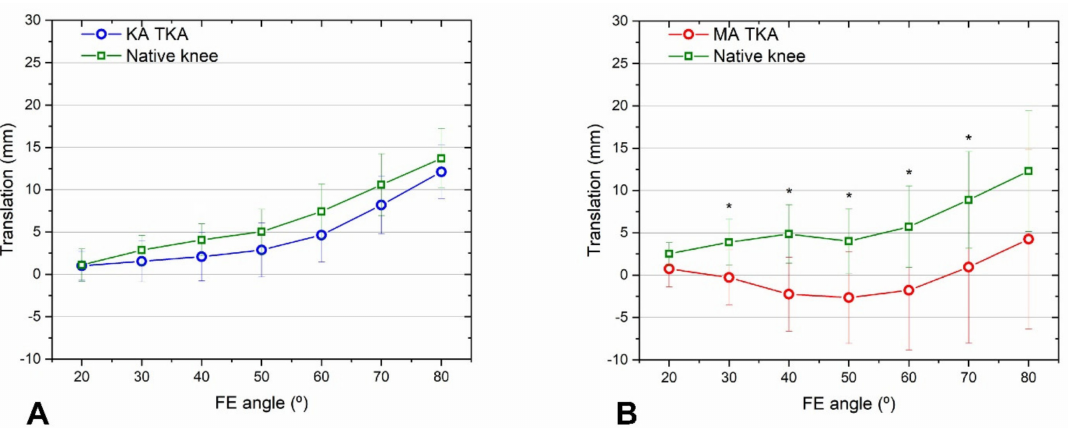
Figure 5. Lateral femoral rollback after KA TKA ( A ) and MA TKA ( B ). Rollback after KA TKA compared to native knee rollback over the entire mid-flexion range, but in the case of MA TKA, the rollback was significantly smaller, except at a flexion angle of 20 ◦ . A paradoxical forward movement was observed after MA TKA. Error bars denote standard deviations. Significant differences ( p < 0.05) are marked with